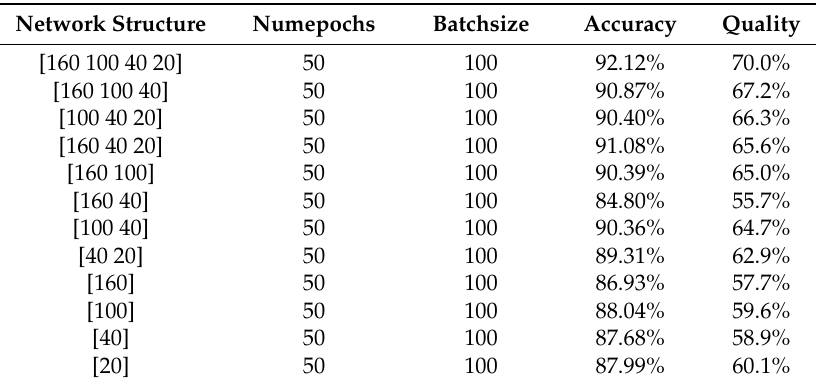
Table 3. Different proportions of extraction results.